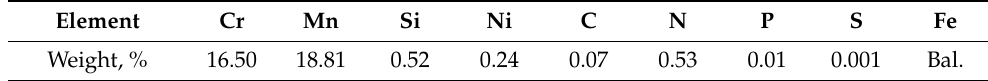
Table 1. Chemical composition of Cr-Mn-N steel.